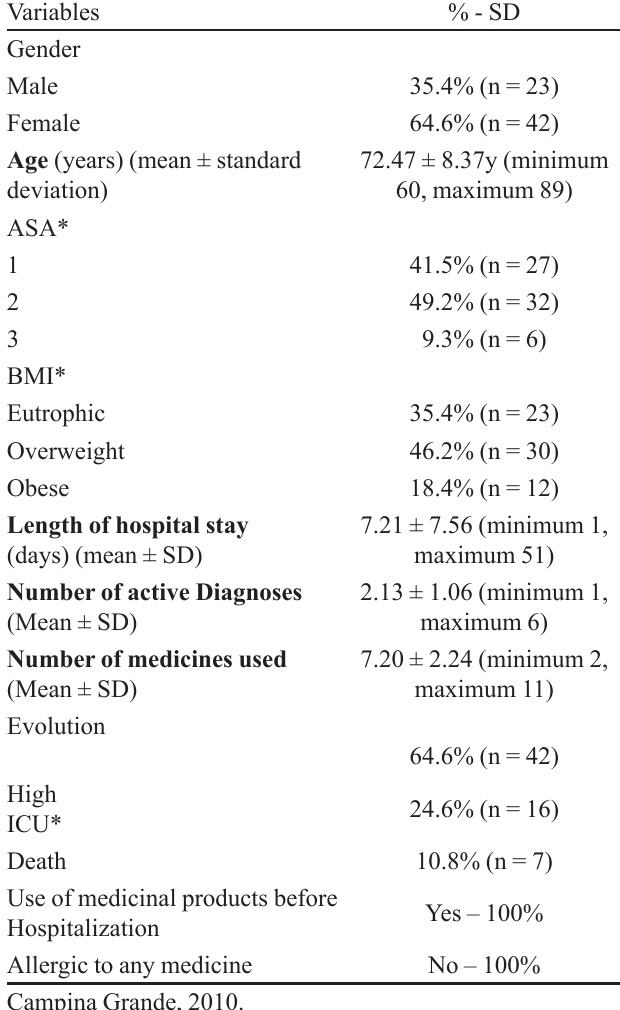
TABLE I - Clinical and Personal Characteristics of Patients